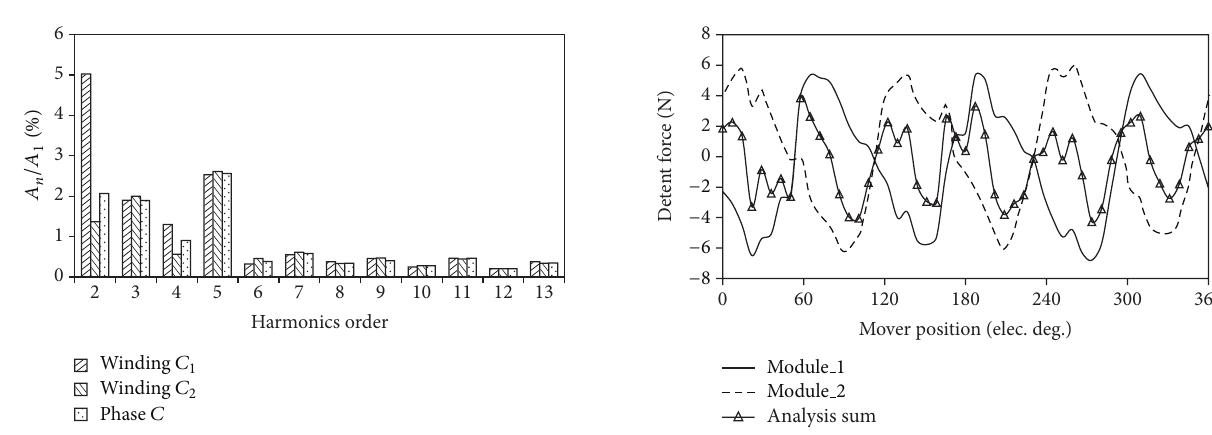
Figure 11: Partial and sum detent forces of proposed machine.